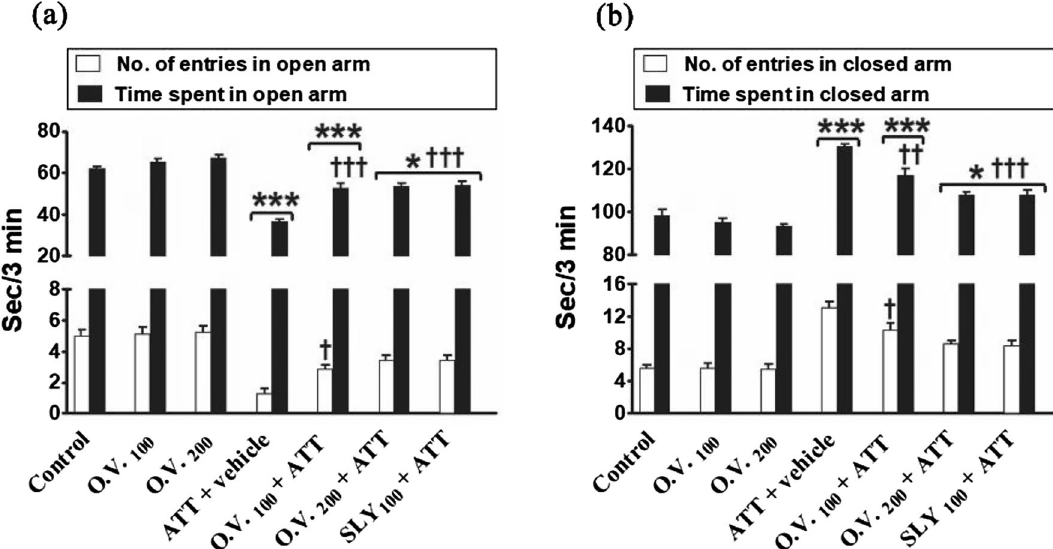
Figure 5. The modulatory effects of O. vulgare on the number of entries and the time spent in the open arm ( a ) and closed arm ( b ) in EPMT in the HE-induced rat model. SEM represented by vertical bars. O.V . : Origanum